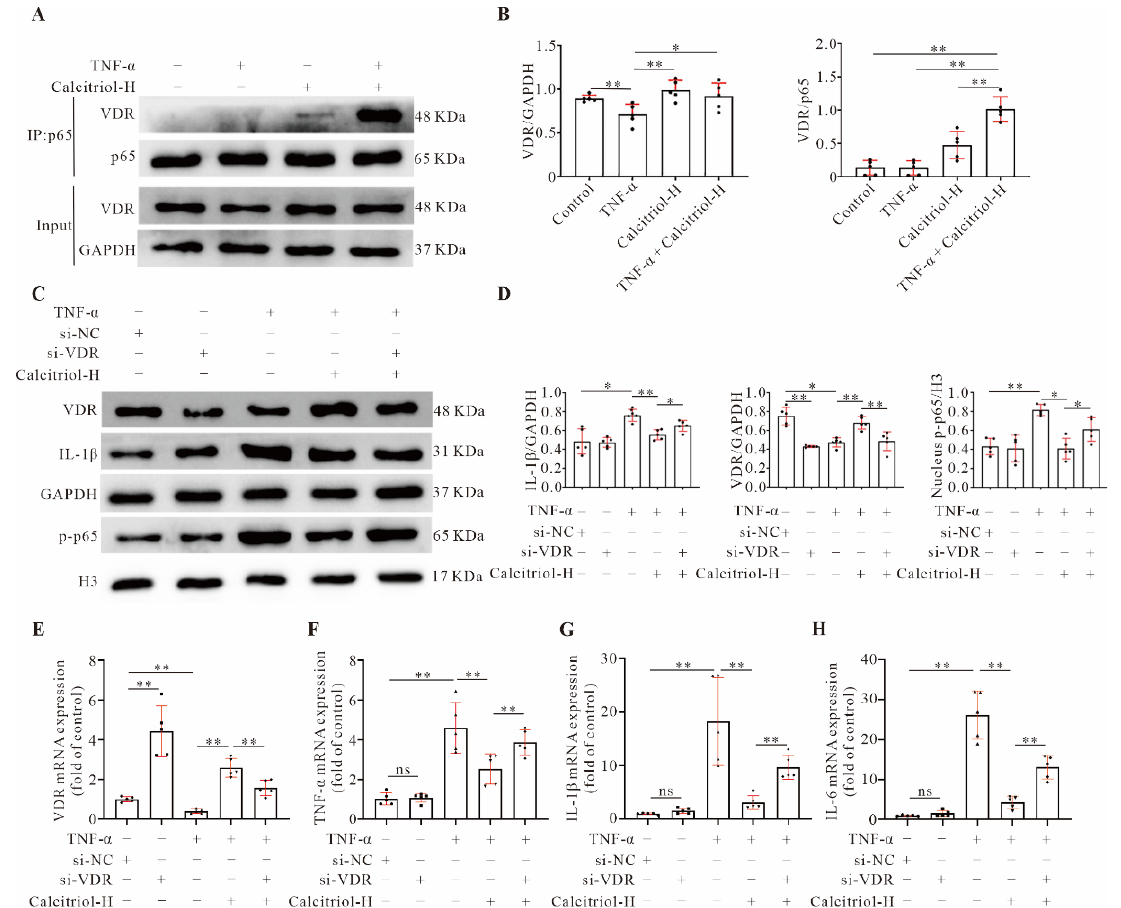
Figure 6. Importance of VDR in calcitriol-regulated inflammatory cytokines expressions. ( A , B ) Cal- citriol increased the interaction of VDR with p65. AC16 cells were stimulated with TNF- α (20 ng/mL) for 24 h in the presence or absence of calcitriol (100 nM). Cell lysates were immunoprecipitated with anti-p65 antibodies and analyzed by Western blotting using anti-VDR and anti-p65 antibodies. Total cell lysates were also immunoblotted with anti-VDR and anti-GAPDH antibodies. Representative